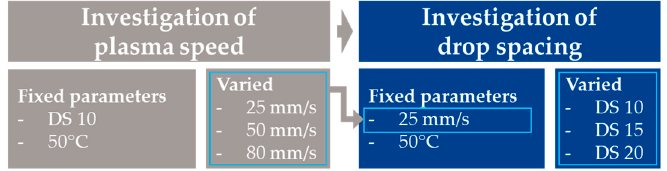
Figure 9. Fixed and varied process parameters for the investigation of drop spacing.